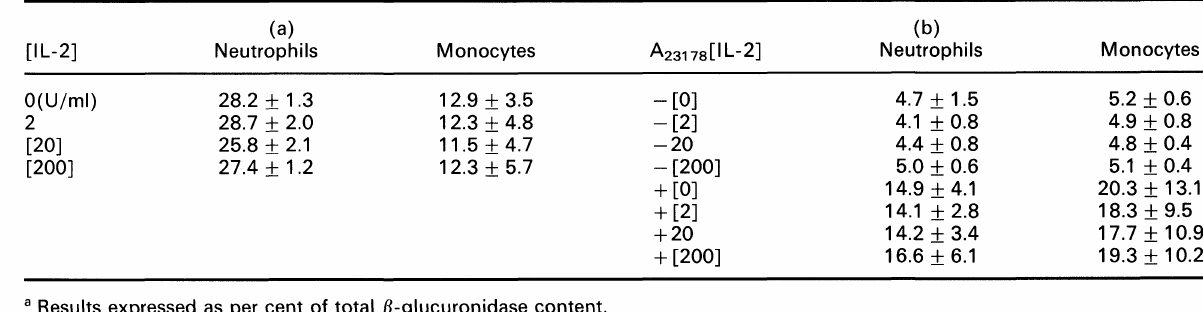
Table 2. (a) Effect of IL-2 on neutrophil and monocyte azurophilic granule release a. (b) Effect of IL-2 on neutrophil and monocyte specific granule release with and without simulation by addition of calcium ionophore A23187 b